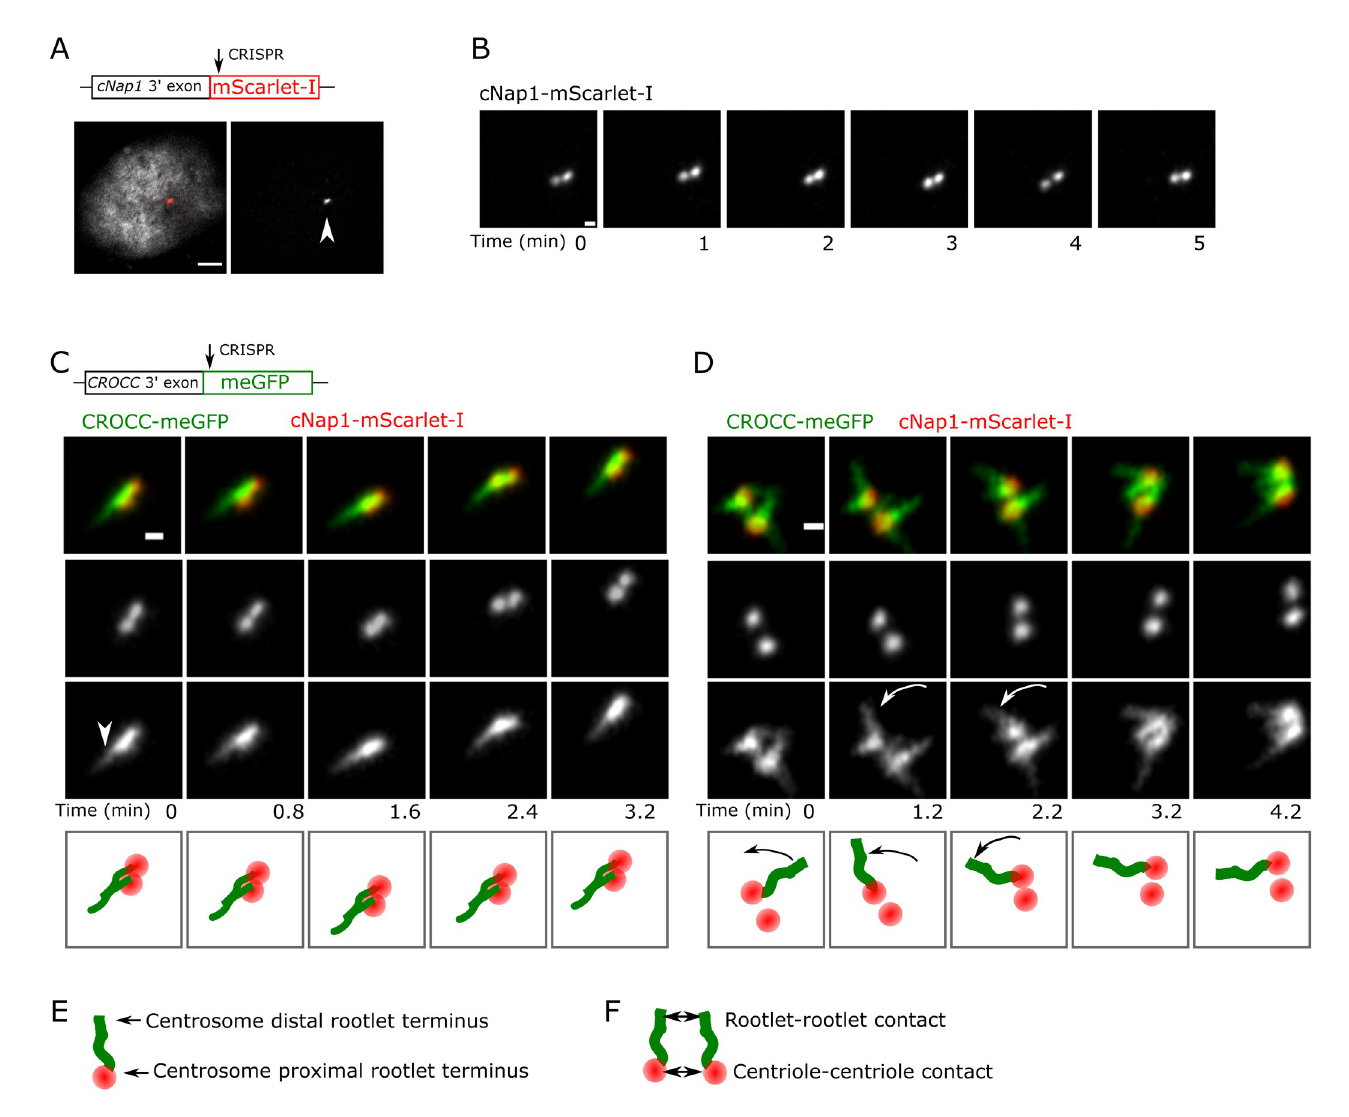
Fig 1. Proximal centriole pairs and rootlets form dynamic contacts during centrosome cohesion. (A) Endogenously tagged cNap1-mScarlet-I localises to regions of high concentration at proximal centrioles (denoted by the arrow). A merged image showing both cNap1-mScarlet-I and the nucleus is shown on the left panel, the right panel shows only cNap1-mScarlet-I. The nucleus is labelled with Hoechst 33342. Scale: 3 μ m. (B) Time-lapse imaging of endogenously tagged cNap1-mScarlet-I at 1-min intervals shows dynamic contacts. The images show a single z-slice from 3D data. Scale: 0.5 μ m. ( C and D ) Time-lapse 2-colour Airyscan imaging of endogenously tagged cNap1-mScarlet-I and rootletin-meGFP. Scale: 0.5 μ m. The arrowhead in ( C ) denotes a potential point of contact between rootlets from different centrioles. The arrows in (D ) denote independent movement of a rootlet distal terminus relative to other rootlets. ( E ) Cartoon depiction of the arrangement of cNap1 and rootletin at centrosomes; centrosome proximal cNap1-mScarlet-I is attached to rootlet termini. ( F ) Cartoon depiction of either rootlet–rootlet or centriole–centriole contact sites. Data underlying this figure can be found in S1–S3